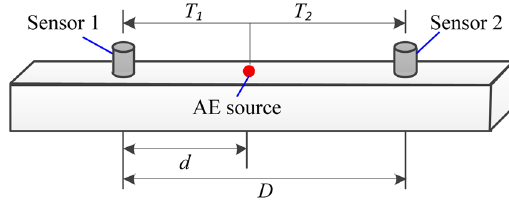
Figure 1. The schematic of the 1D linear